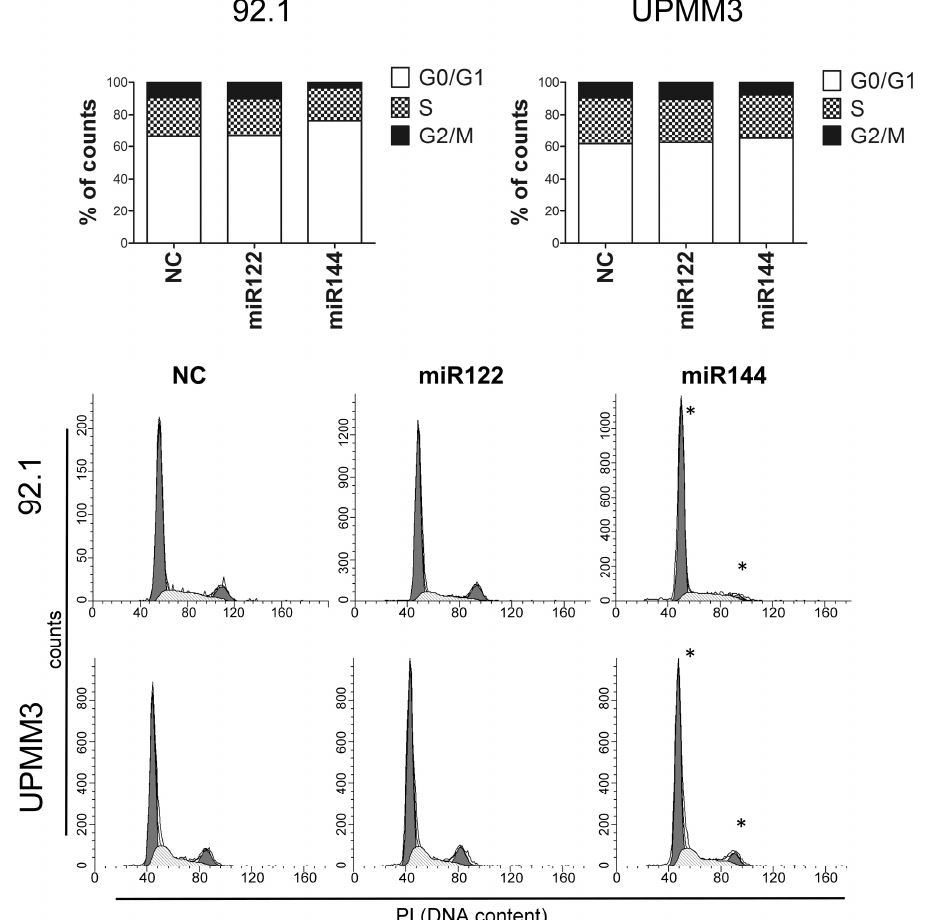
Figure 7. Cell cycle analysis of UM cells transfected with miRs mimic. Stacked plots are mean of three different experiments of 92.1 and UPMM3 cells transfected with irrelevant miR (NC), miR122 or miR144 mimic, 72 h after transfection. Standard deviation was below 5% of the mean. Representative cell cycle histogram analysis of 92.1 and UPMM3 miRs transfected cells shows a statistically significant increase in G0/G1 and decrease in G2/M phases in miR144 transfected cells (* p = 0.03). Histograms: x -axis: PI in FL2-Area (DNA content), y -axis: counts. 2.5. miR122 and miR144 Directly Target 3’UTR Region of Both ADAM10 and c-Met